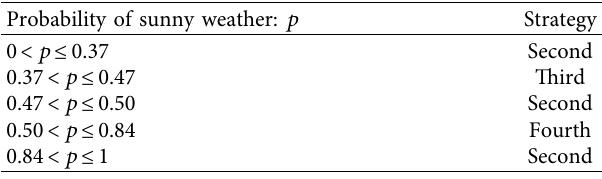
Table 11: The best strategy in Level 4. Probability of sunny weather: p Strategy